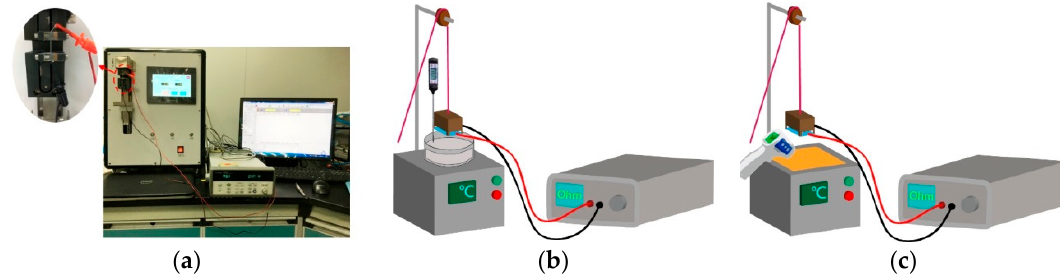
Figure 2. Experimental setup for tensile test of the wrapped yarns ( a ); and resistance change with different temperature in oil-bath ( b ) and hotplate stage ( c ).